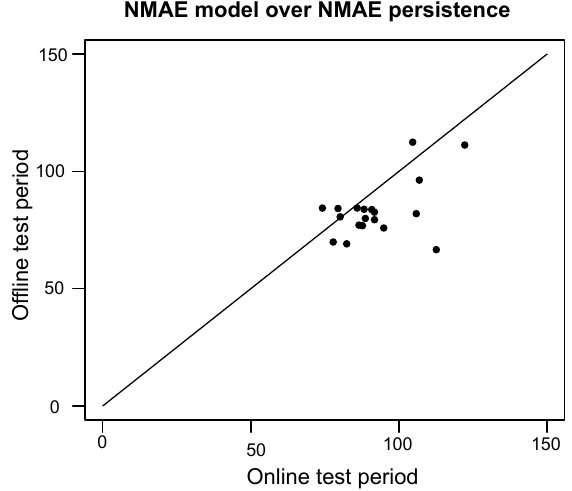
Figure 6. Each point represents the household performance on the online test period ( x -axis)—1 April to 31 August 2018 —compared to the performance on the offline test period ( y -axis)—1 October to 31 December 2015. The performance is the ratio between the NMAE obtained with the forecasting framework and the NMAE obtained with a 1-day persistence model.